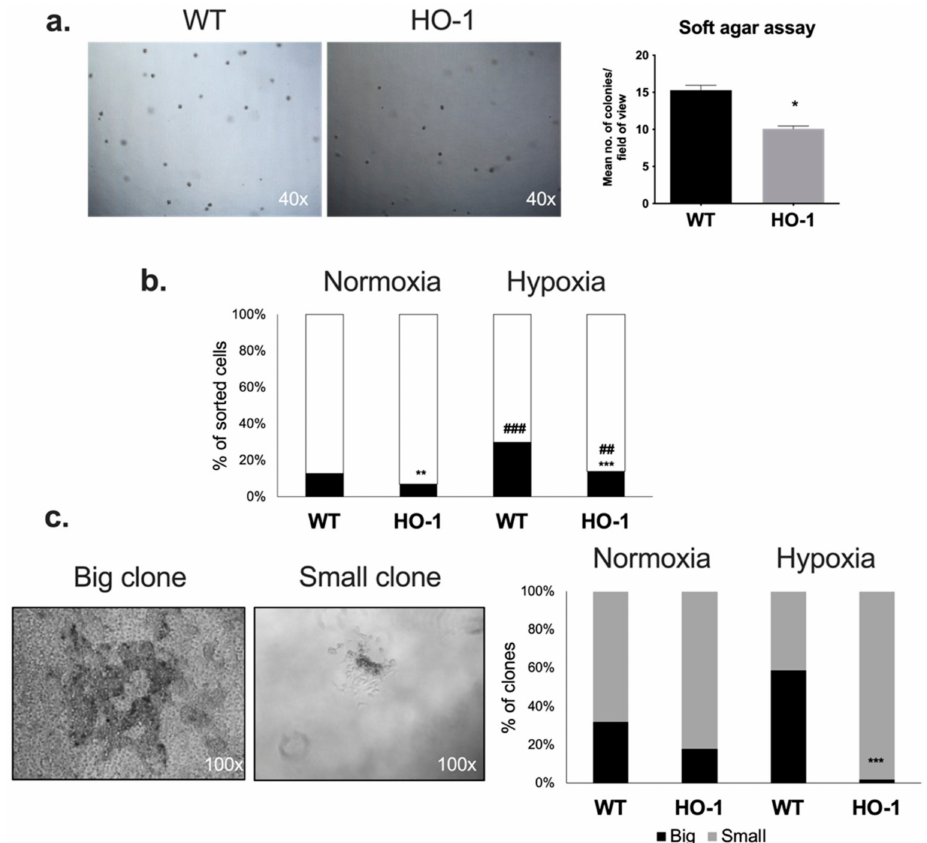
Figure 3. Effect of HO-1 overexpression on the clonogenic potential of B16-F10 melanoma cells. ( a ) Soft agar assay performed using WT and HO-1-overexpressing cells. Microscopic view of melanoma spheres 7 days after seeding. Numbers of spheres were calculated by two indepen- dent scientists (n = 2, each bar represents mean + SEM; * p < 0.05). ( b ) Percentage of cells that formed stable clones 13 days after single-cell sorting (n = 239–624, Fisher exact test; ** p < 0.01, *** p < 0.001 versus WT cells; ## p < 0.01, ### p < 0.001 versus normoxia). ( c ) Size of clones formed by WT and HO-1 melanoma cells in normoxia and hypoxia, 13 days after single-cell sorting (n = 39–76, Fisher exact test; *** p < 0.001 versus WT